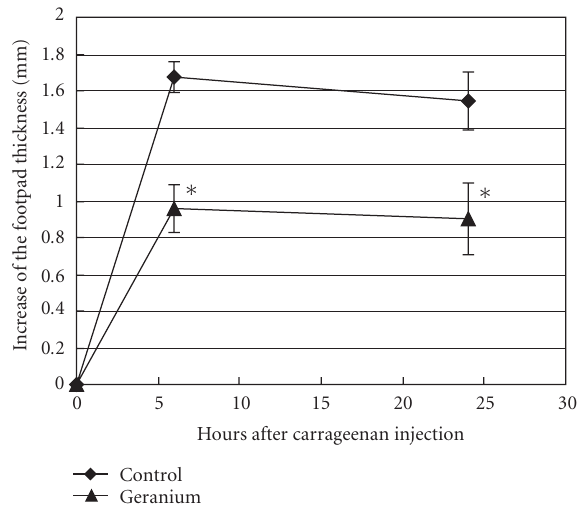
Figure 1: E ff ects of intraperitoneal administration of geranium oil on foot swelling induced by carrageenan injection. Carrageenan was injected to left footpad of mice, and 10 minutes after the injection, geranium oil or DMSO was given intraperitoneaouly. Six and 24 hours later, the increase of the foot thickness was measured. Each value represents an average from 5 mice and the standard error. ∗ P < . 05 di ff erence from control.